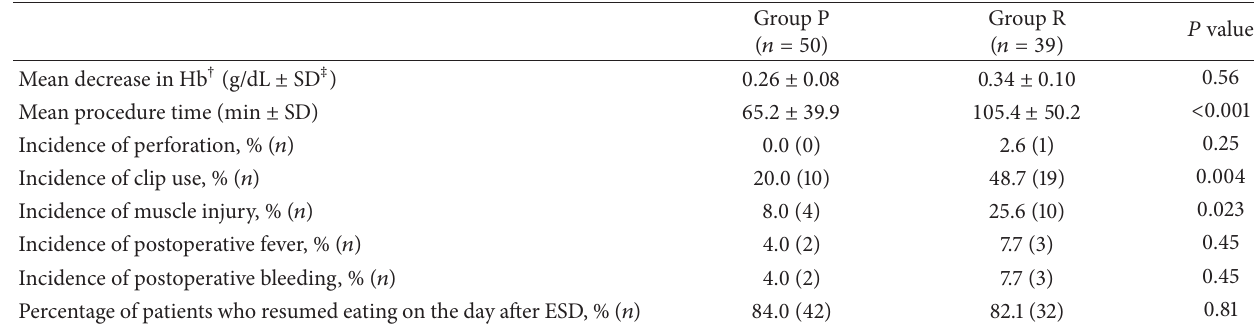
Table 2: Overall results of this study.